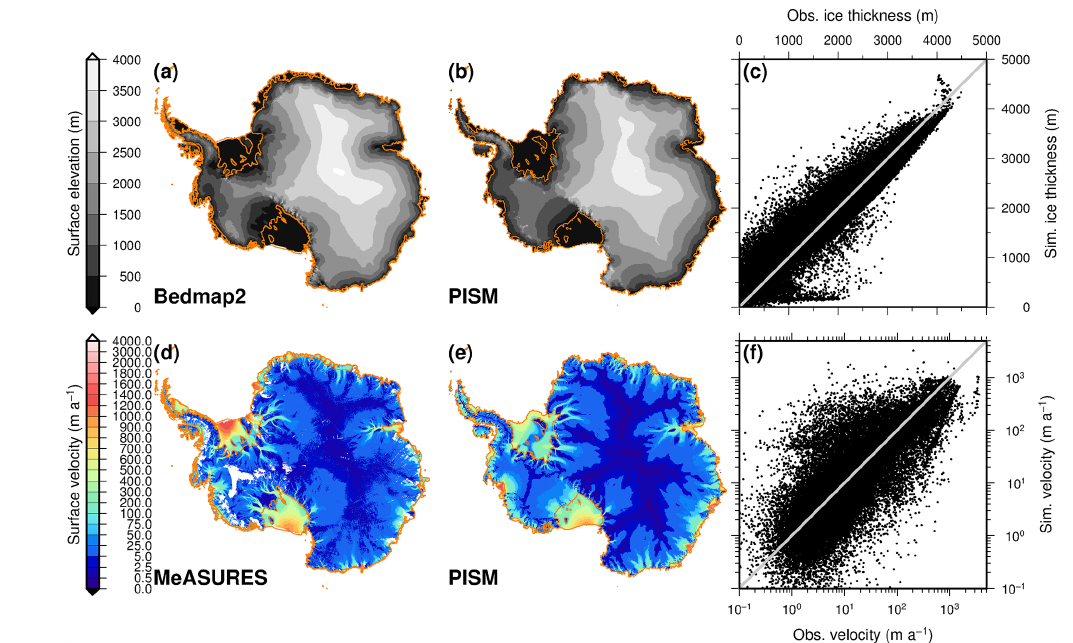
Figure E11. Comparison between the initial state PISM2Eq and observational estimates. Panels (a–c) depict the surface elevation using (a) the Bedmap2 data set (Fretwell et al., 2013), (b) the elevation in PISM, and (c) a point-wise comparison. Panels (d–f) show the sur- face velocity using (d) observations (Rignot et al., 2016), (e) simulated values, and (f) a point-wise comparison. The reader is referred to Fig. E10 (PISM1Eq) for further details and to Table F1 for essential information and a comparison of both states.